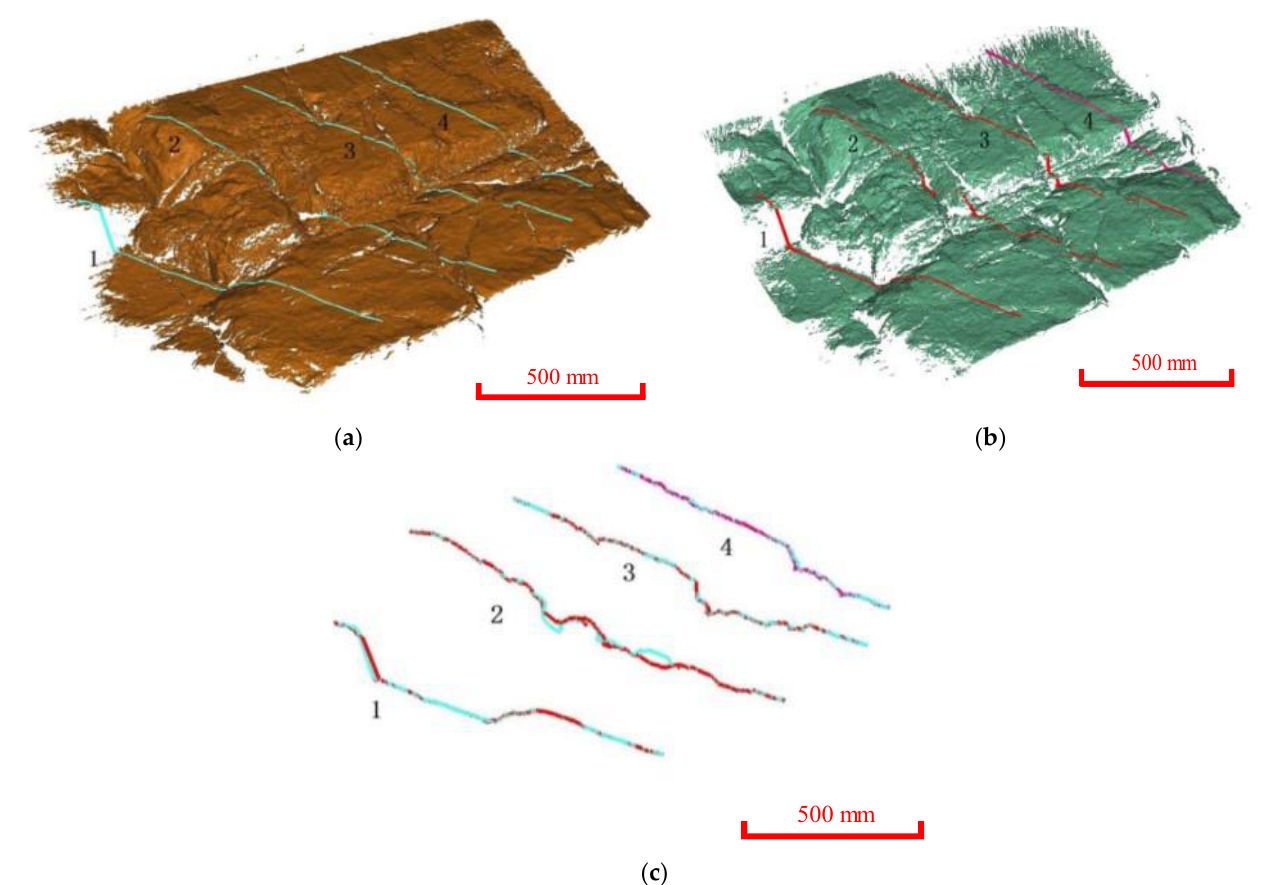
Figure 11. Comparison of typical sections of Yangjiaping bank slope; ( a ) The location of the typical sections (17 August 2019). ( b ) The location of the typical sections (12 July 2020). ( c ) The superposition of two-period measurement data.